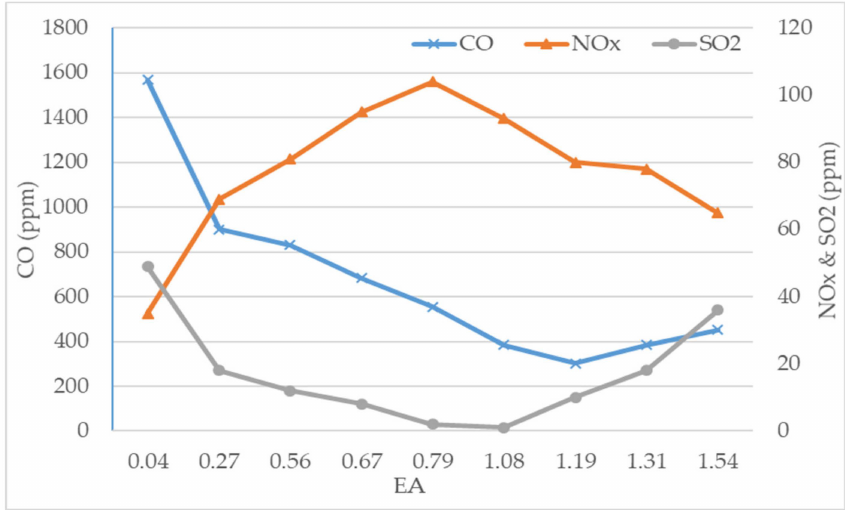
Figure 5. E ff ect of EA ratio on CO, NO x , and SO 2